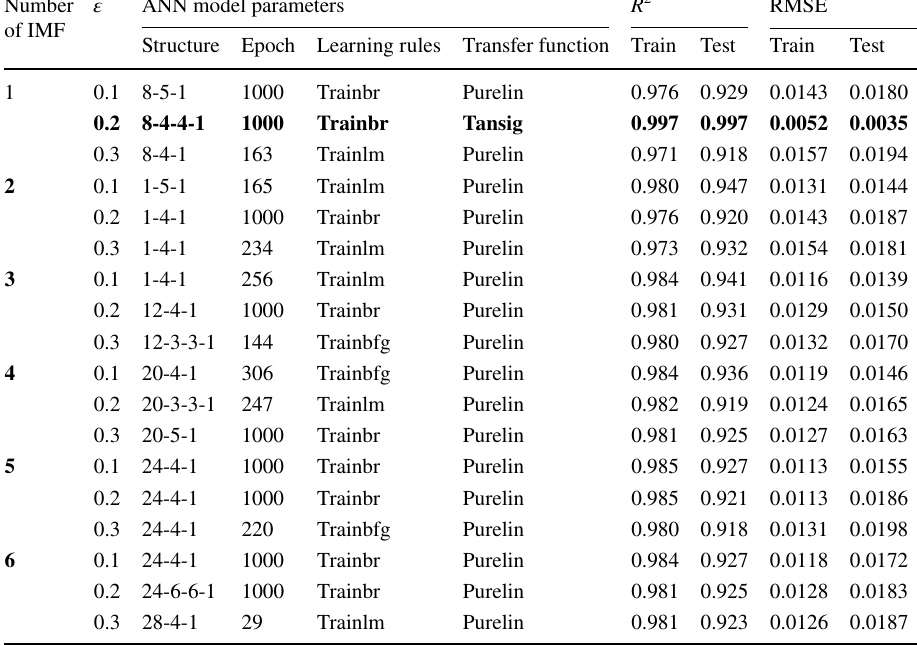
Bold values represent the